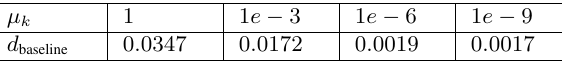
Table 4: Absolute distance in mm between the length of the cal- ibrated baseline and the mean of the reconstructed baselines for the case that the stereo constraint is enforced at the end of the reconstruction phase.